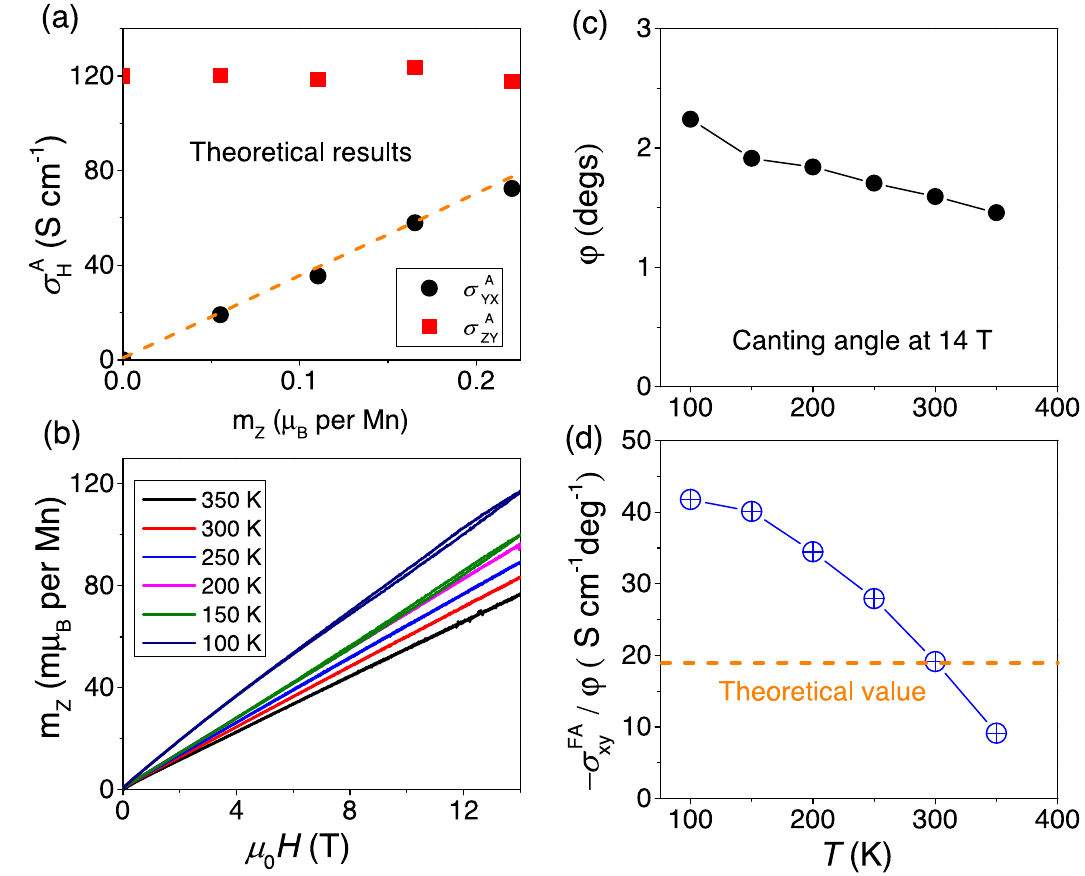
Fig. 3 | Comparison between theory and experiment. a Comparison of the the- oreticalcalculatedanomalousHallconductivityindifferentHallcon fi gurations(YX and ZY). The σ A zy shows a fl atbehavior, but the σ A yx shows a fast increasing with the m Z . b The fi elddependentcantingmoment( m Z )withtemperaturevaryingfrom350